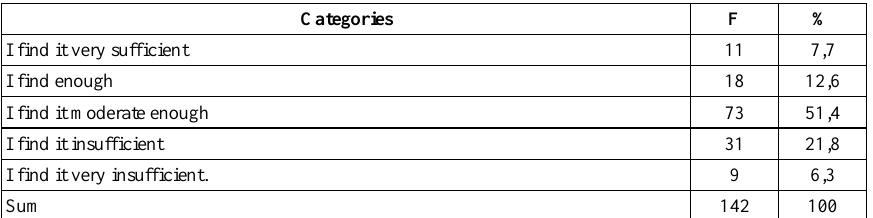
Table 4. Opinions of students regarding their level of seeing themselves as a technology literate Categories F